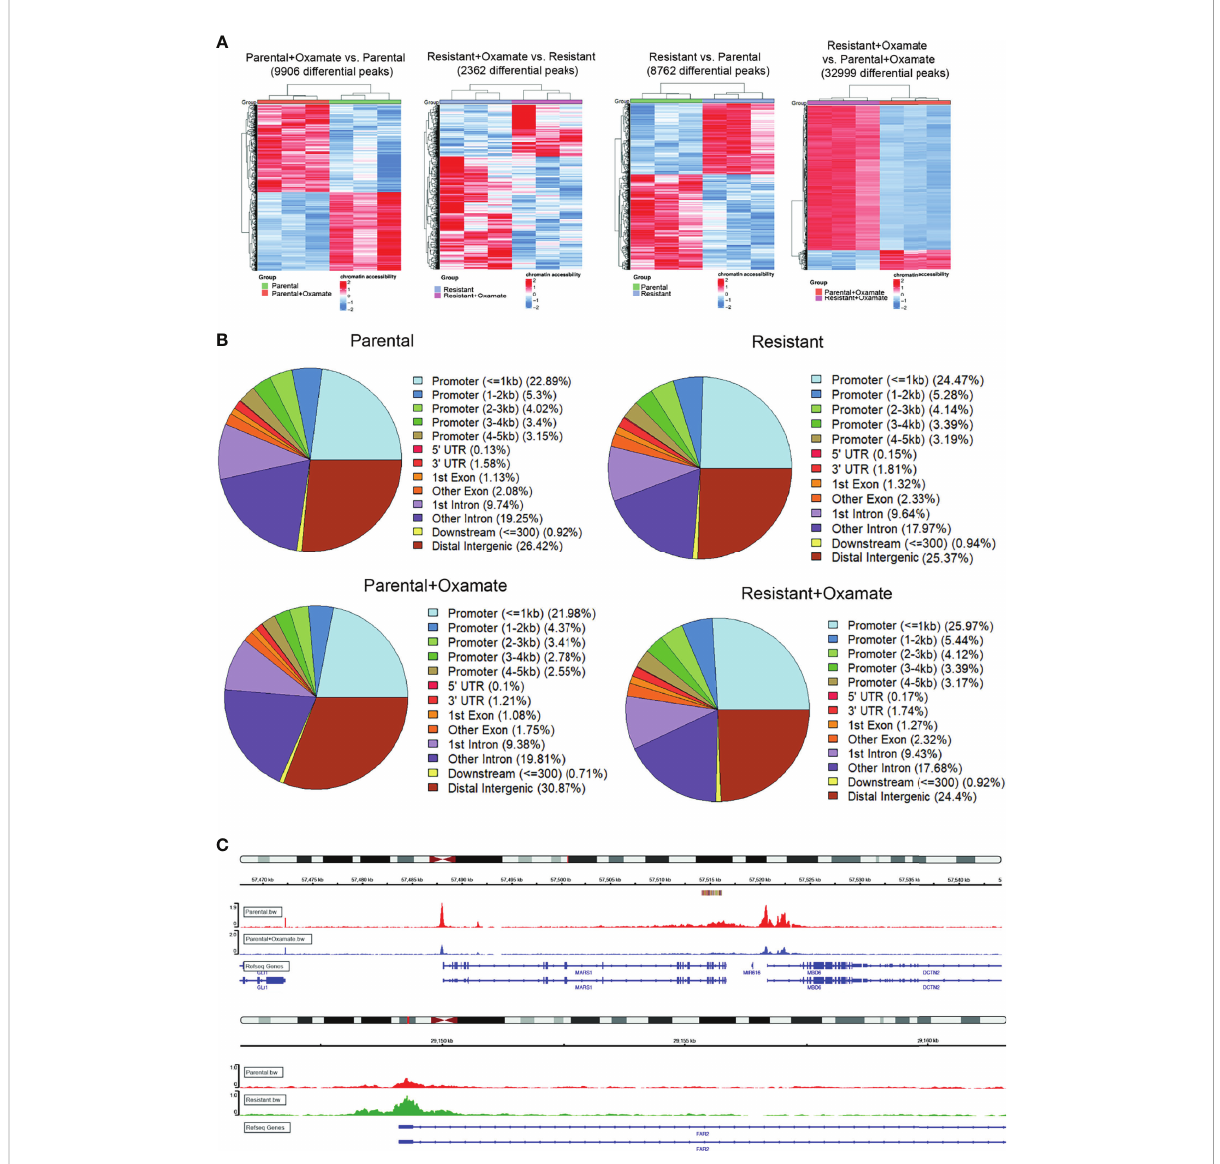
FIGURE 2 ATAC-seq analysis of parental and oxamate-resistant MIAPaCa2 cells. (A) Heatmaps showing differential genomics regions with increased or decreased chromatin accessibility based on ATAC-seq identi fi ed in the indicated comparisons. (B) Pie-chart for the indicated samples mapping the locations of annotated peaks identi fi ed by ATAC-seq. (C) IGV tracks for the indicated genomic regions for the indicated